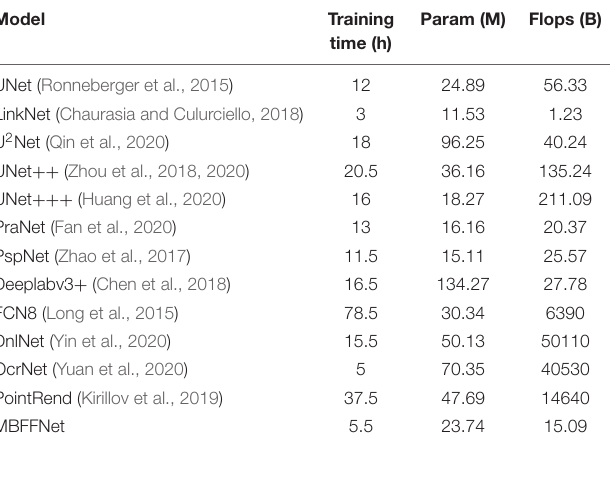
TABLE 3 | Analysis of the number of parameters and the number of calculation.